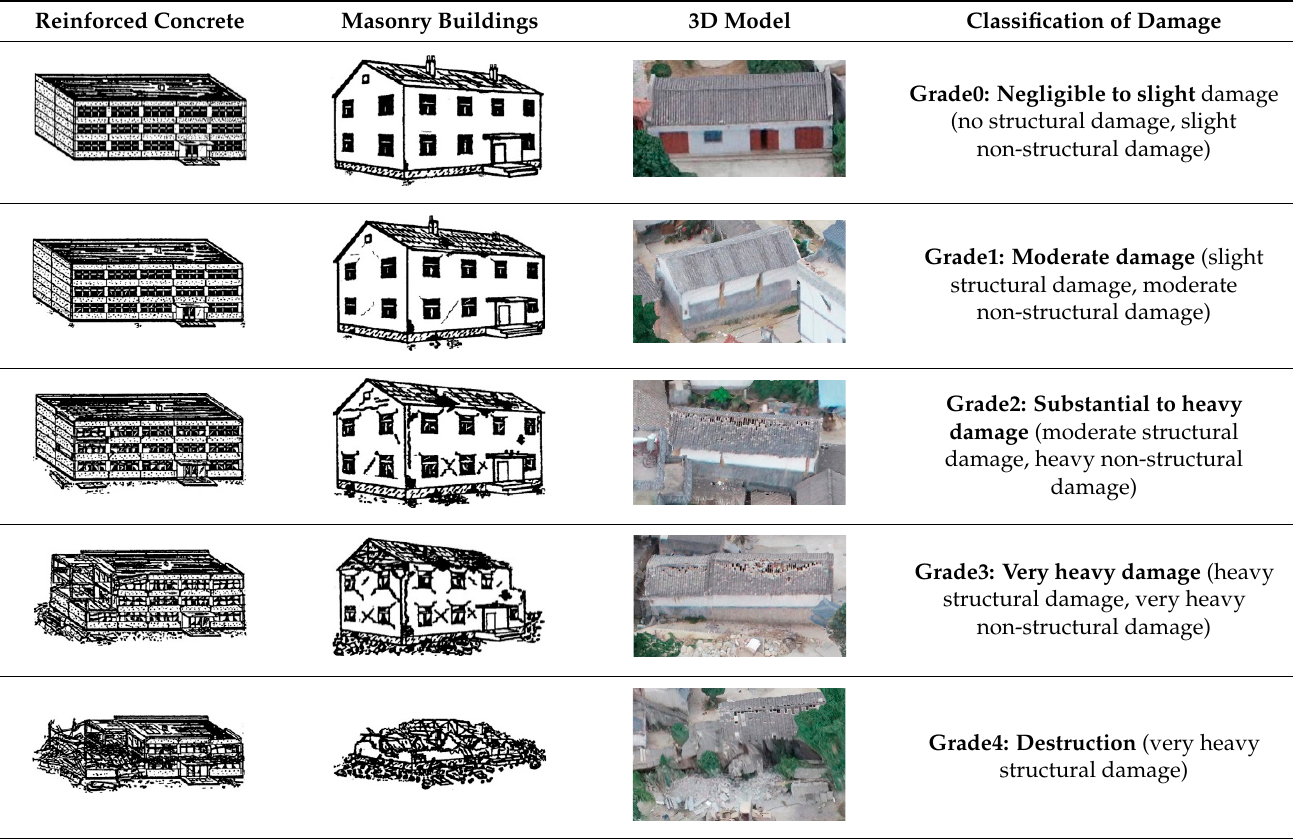
Table 1. Detailed description of buildings with different damage level.